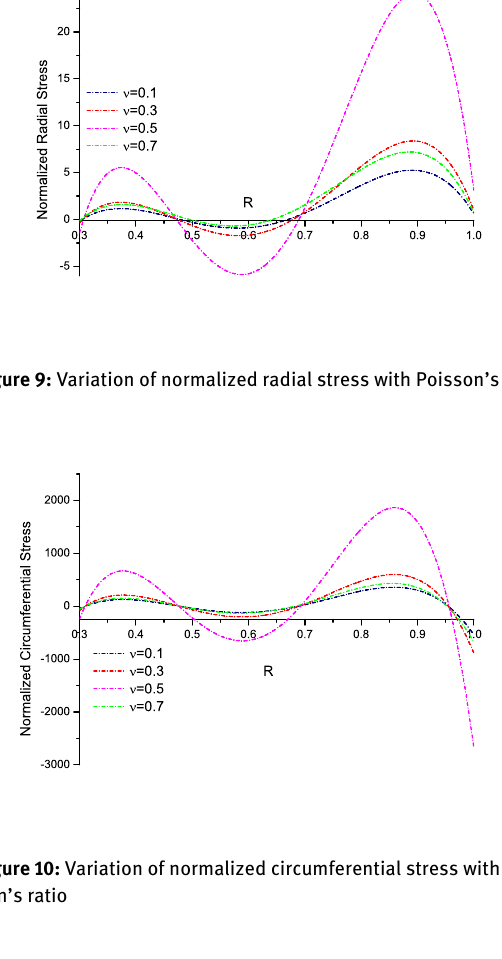
Figure 8: Normalized axial Stress distribution in FGM hollow cylin- der with different values of T 0